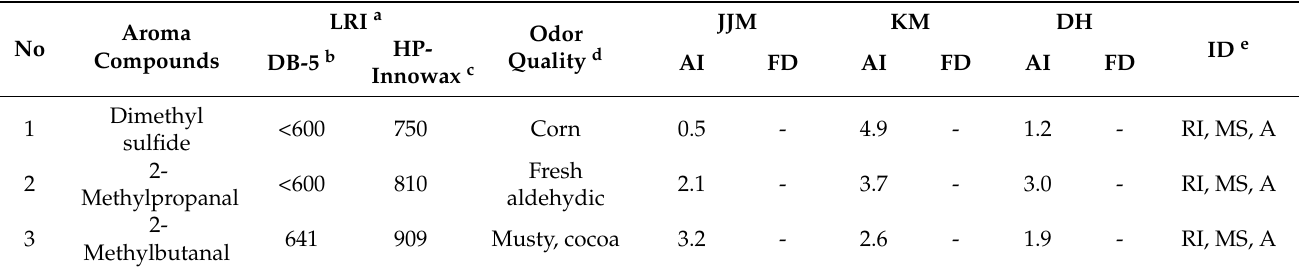
Table 1. Comparison of flavor dilution factor (FD) and aroma intensity (AI) of the aroma